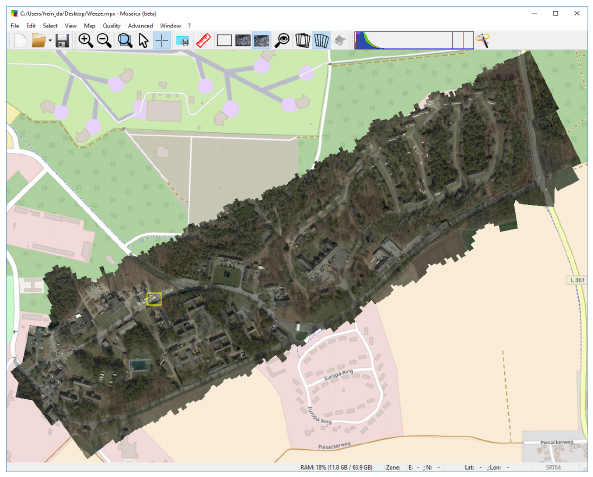
Figure 6. Quick-mosaic of a captured area comprising about 800 , 000 m 2 . The visualized scene is rendered out of 1 , 093 single aerial images (approx. 20GB image data) with an average ground resolution of about 3 . 5 cm . A detail view of the yellow rect section is shown in figure 7